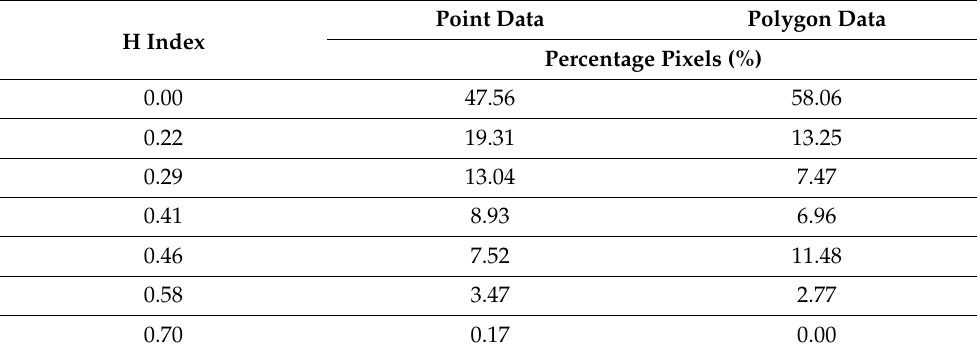
Table 3. Percentage distribution of H-index values in the total area, using different sampling strate- gies: comparison between all